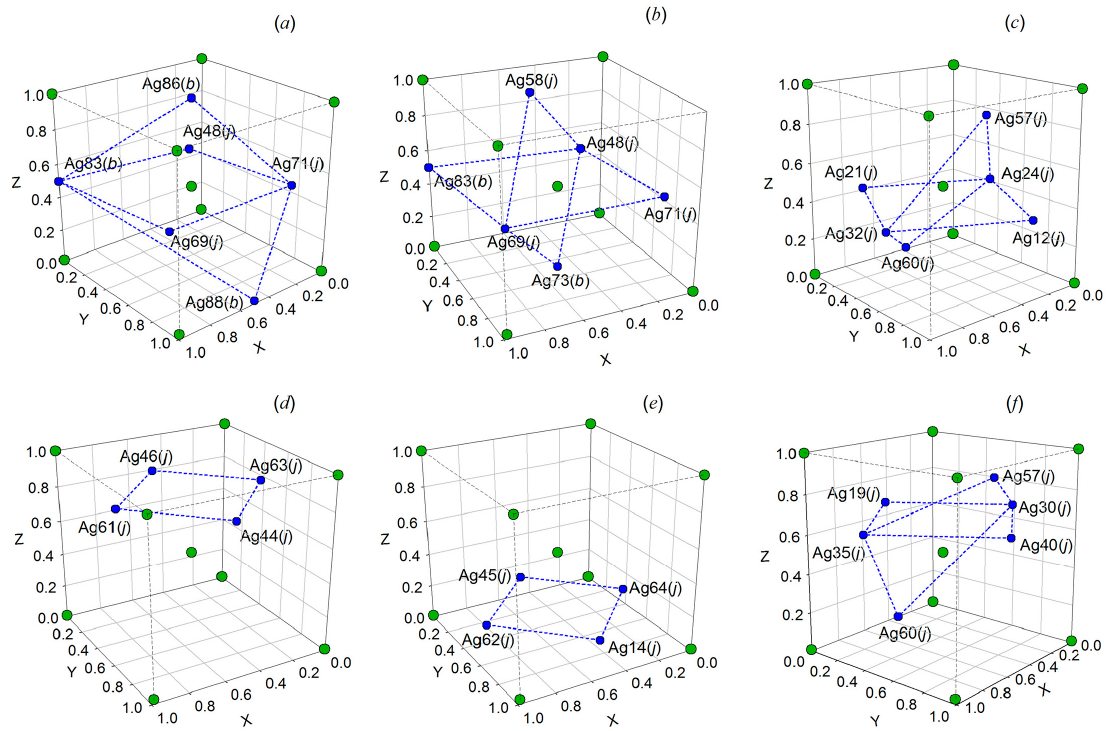
Figure 18. Some of the simulated possible arrangements of four Ag atoms with the location a portion of the Ag atoms in the same plane of the unit cell of cubic β -Ag 2 S argentite: ( • ) metal sites oc- cupied by Ag atoms, ( • ) nonmetal sites 2 ( a ) occupied by S sulfur atoms.